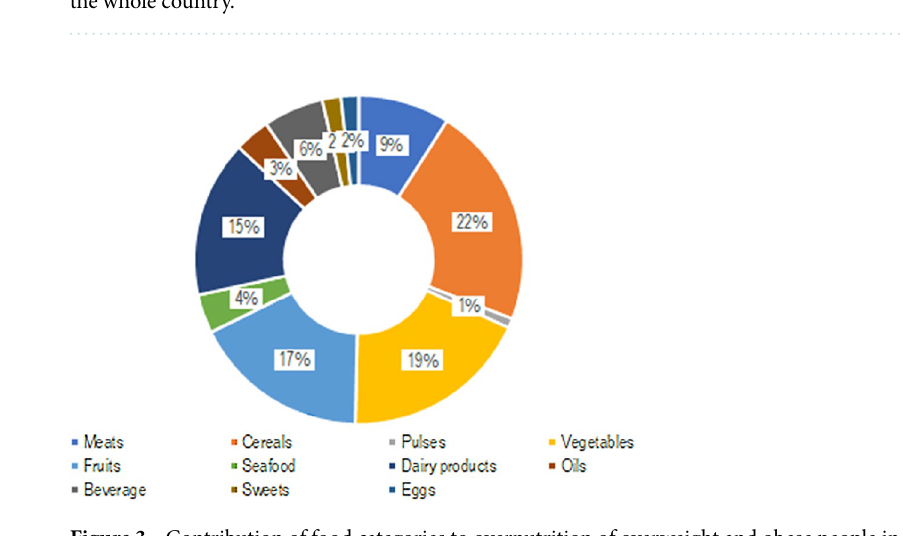
Figure 3. Contribution of food categories to overnutrition of overweight and obese people in Italy. The Figure represents the percentage contribution of each food category to the total food consumed in excess in the whole